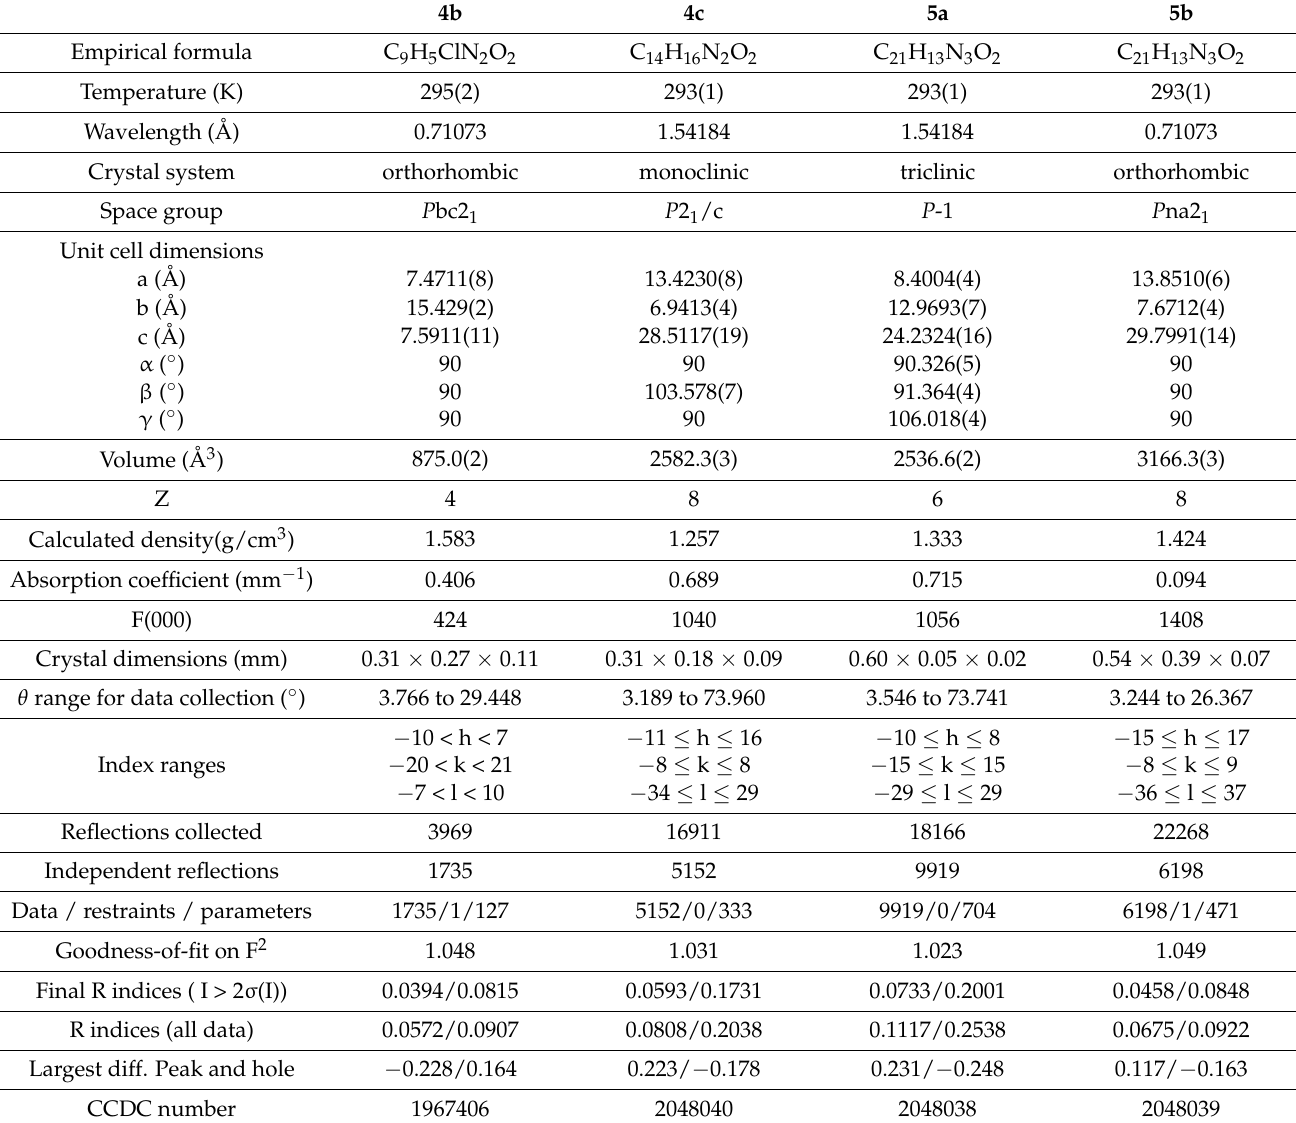
Table 2. Crystal data and structure refinement details of compounds 4b, 4c , 5a, and 5b